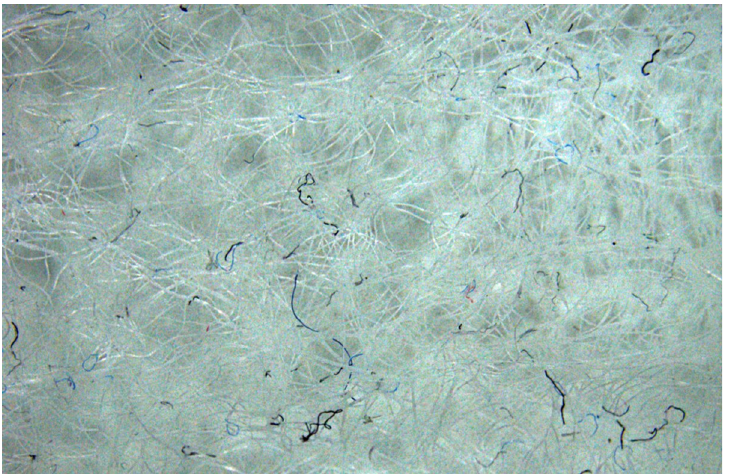
Fig 6. Image of dryer sheet after